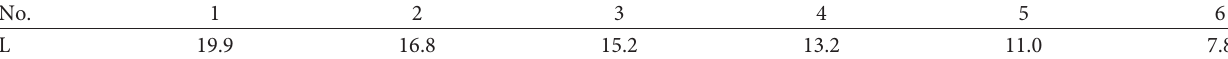
Table 1: Effective length of strand (unit: